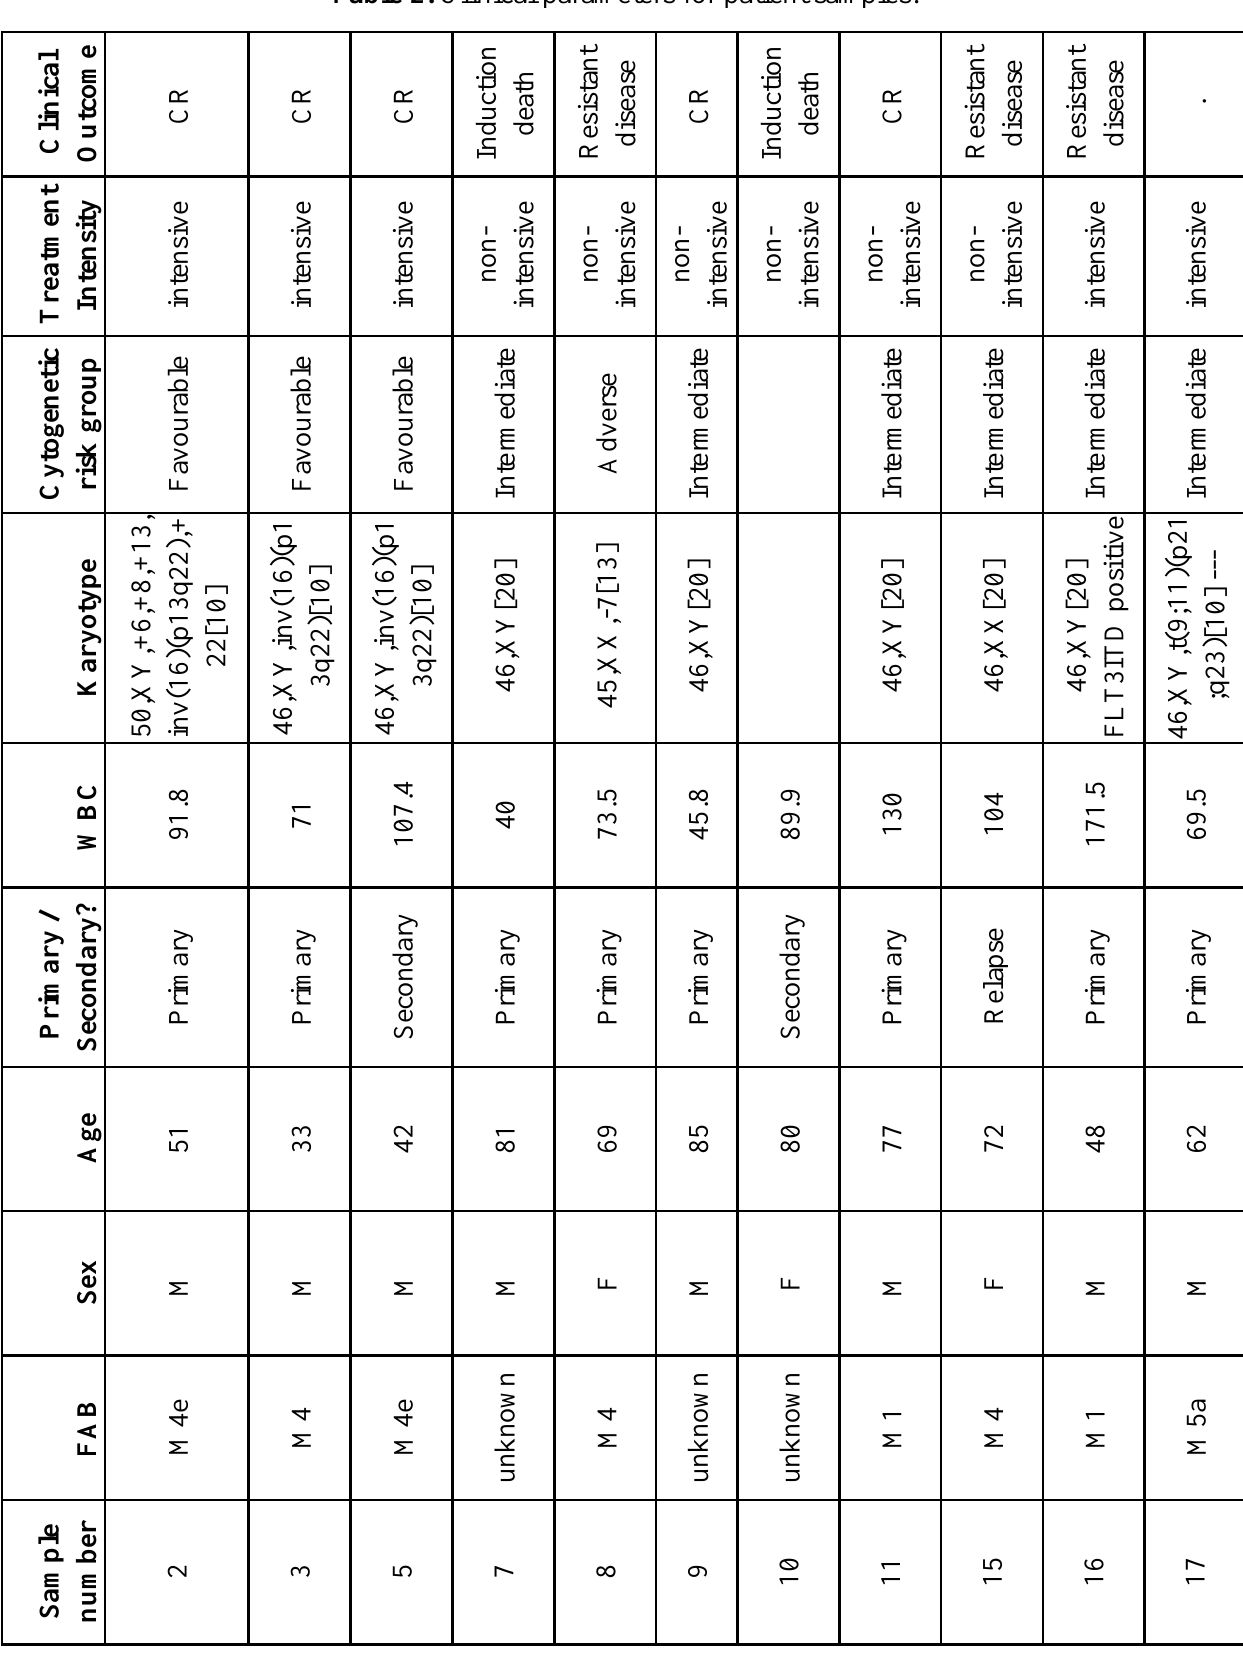
Table 2. Clinical parameters for patient